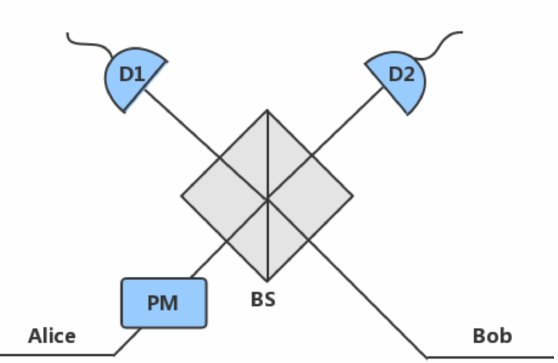
Figure 2. Mesurement setup used in phase-matching QKD